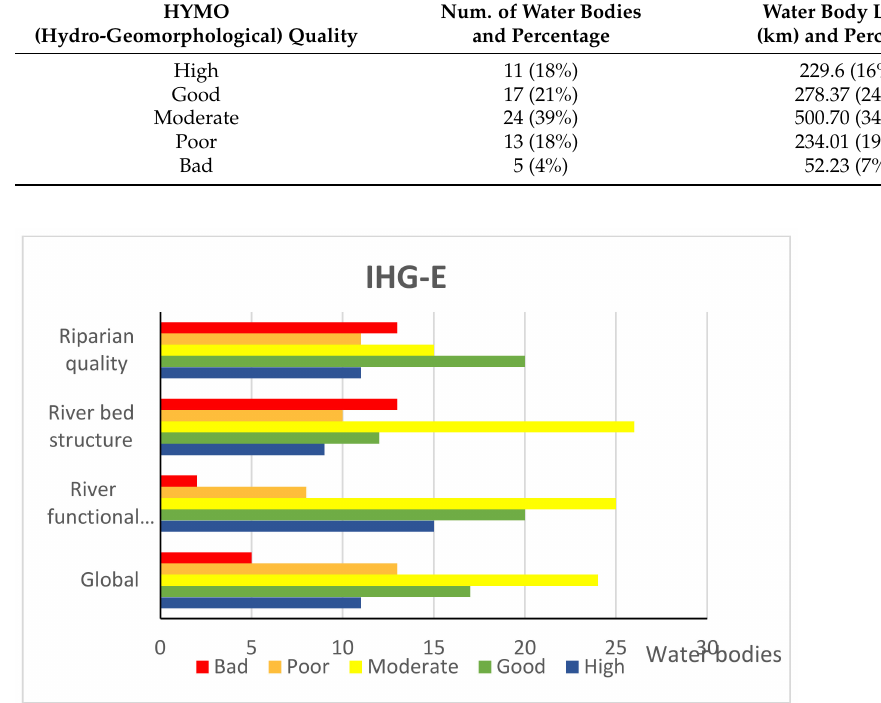
Figure 5. Number of river water bodies classified according to the Hydro-geomorphological quality index adapted to temporary rivers, IHG-E [50]. The global IHG-E results, and the three main quality elements: the river functional quality, river bed structure, and the riparian quality, are shown. The IHG-E index was applied to 70 ephemeral river water bodies in the J ú car